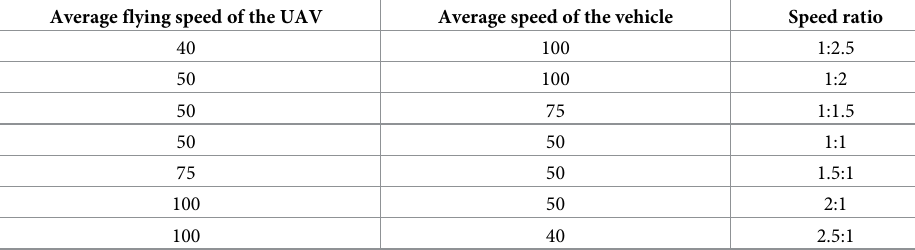
Table 5. Combinations of UAV and vehicles at different speeds.